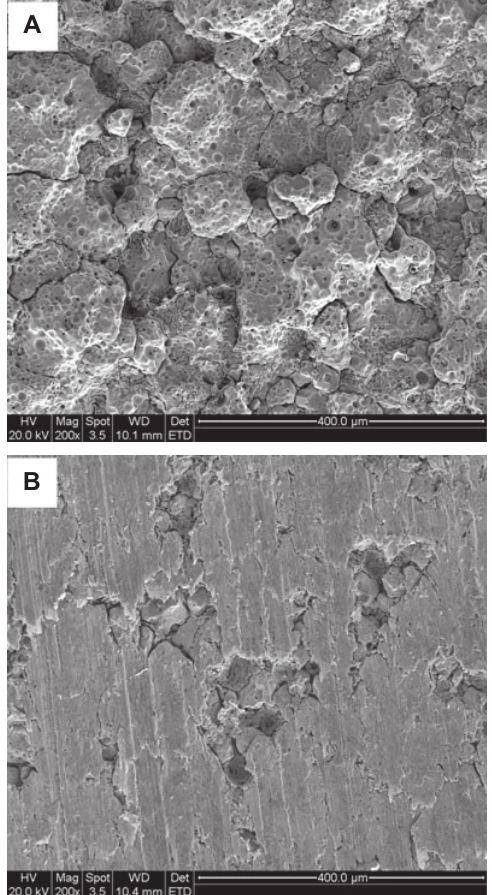
Figure 7 SEM micrographs showing the surface of TiC/316L composites exposed to 15 wt. % H conventional PM technique; (B) prepared by